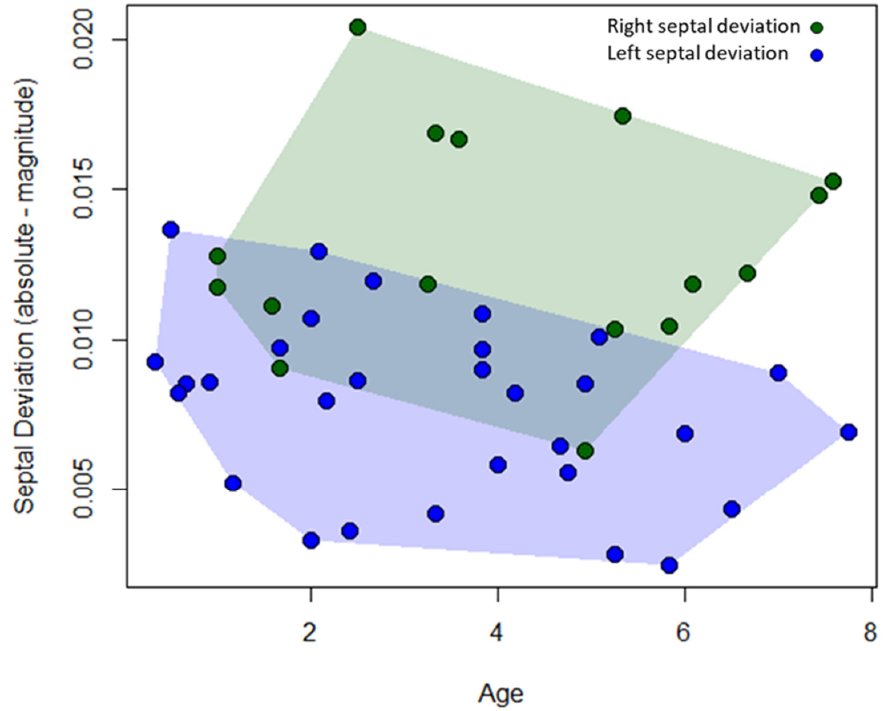
Figure 5. Scatter distribution plot showing absolute magnitude values of septal deviation along the y -axis, and ontogeny (changes in age) along the x -axis. Right and left deviations are highlighted respectively in green and blue. Sample size: 46 specimens.